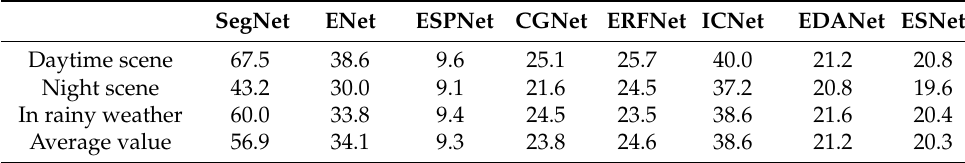
Table 1. Efficiency comparison table of different methods